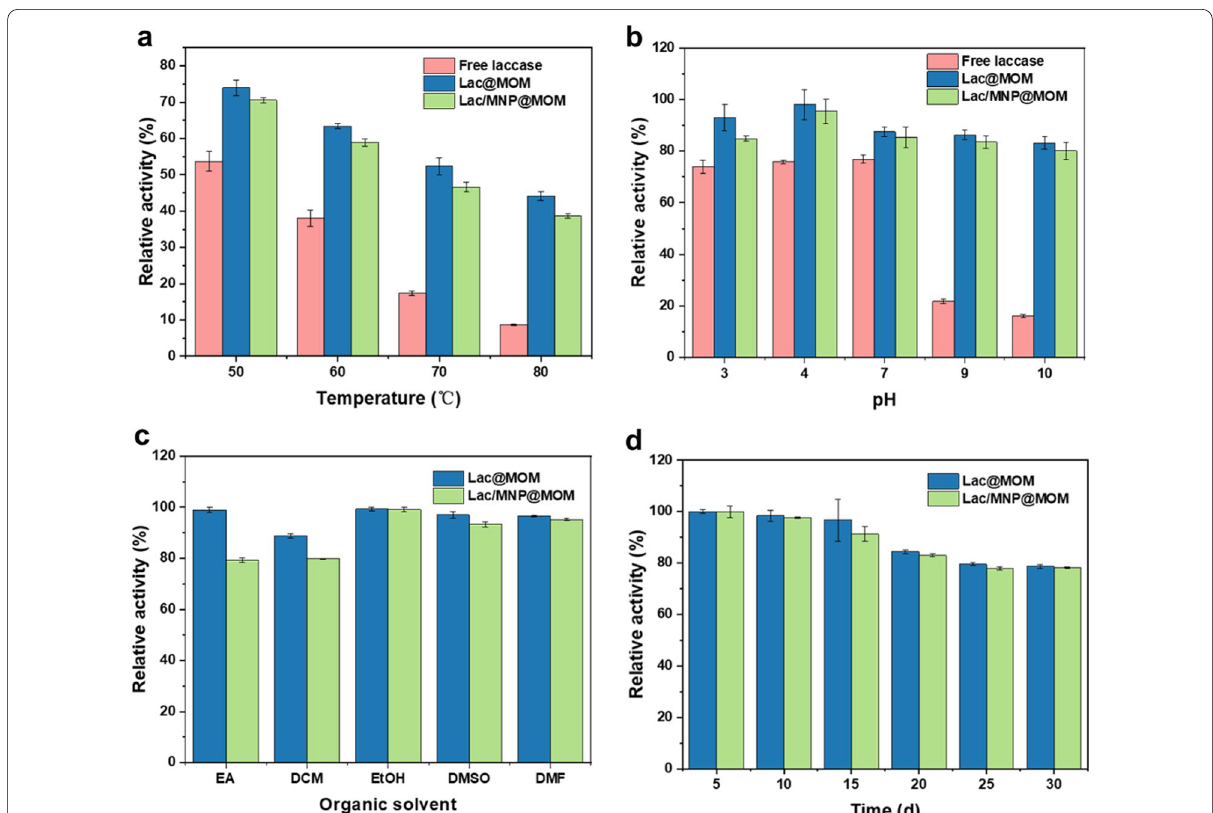
Fig. 4 a Thermal inactivation of free laccase (red), Lac@MOM (blue), Lac/MNP@MOM (green) at 50 ℃ , 60 ℃ , 70 ℃ and 80 ℃ for 30 min; b pH condition deactivation of free laccase (red), Lac@MOM (blue), Lac/MNP@MOM (green) at different pH conditions for 30 min; c Organic solvent stability evaluation of Lac@MOM (blue), Lac/MNP@MOM (green); d Storage stability of Lac@MOM (blue) and Lac/MNP@MOM (green) (4